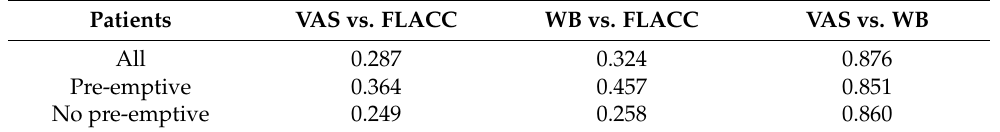
Table 5. The values of the intra-class correlation coefficients (ICC) assessing the compliance of the results of pain level measurements on the WB, VAS, and FLACC scales.